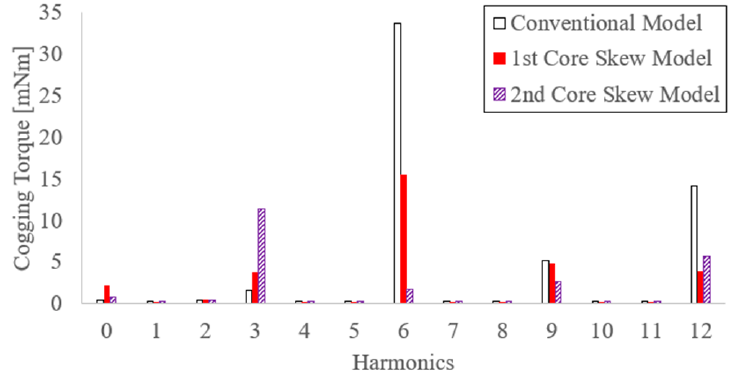
Figure 11. Spectra of cogging torque for each model.